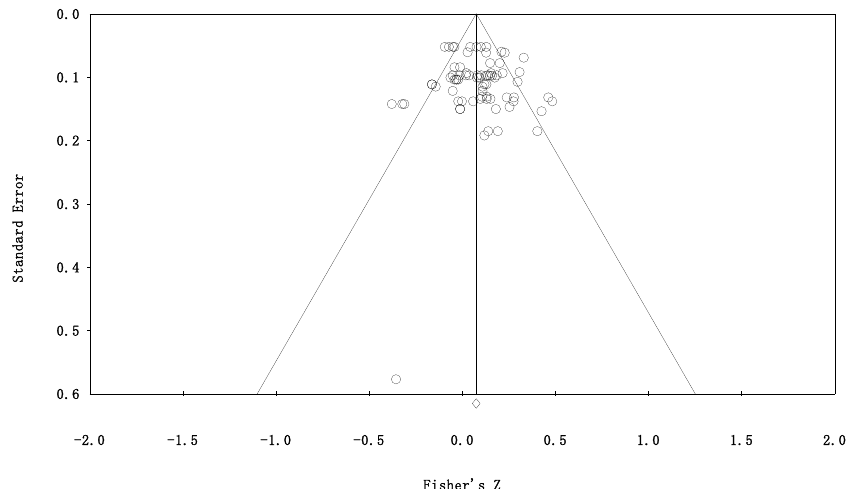
Figure 6. Funnel plot of this study to assess the publication bias. X –axis indicates the individual study effect estimates, and Y -axis indicates standard errors.